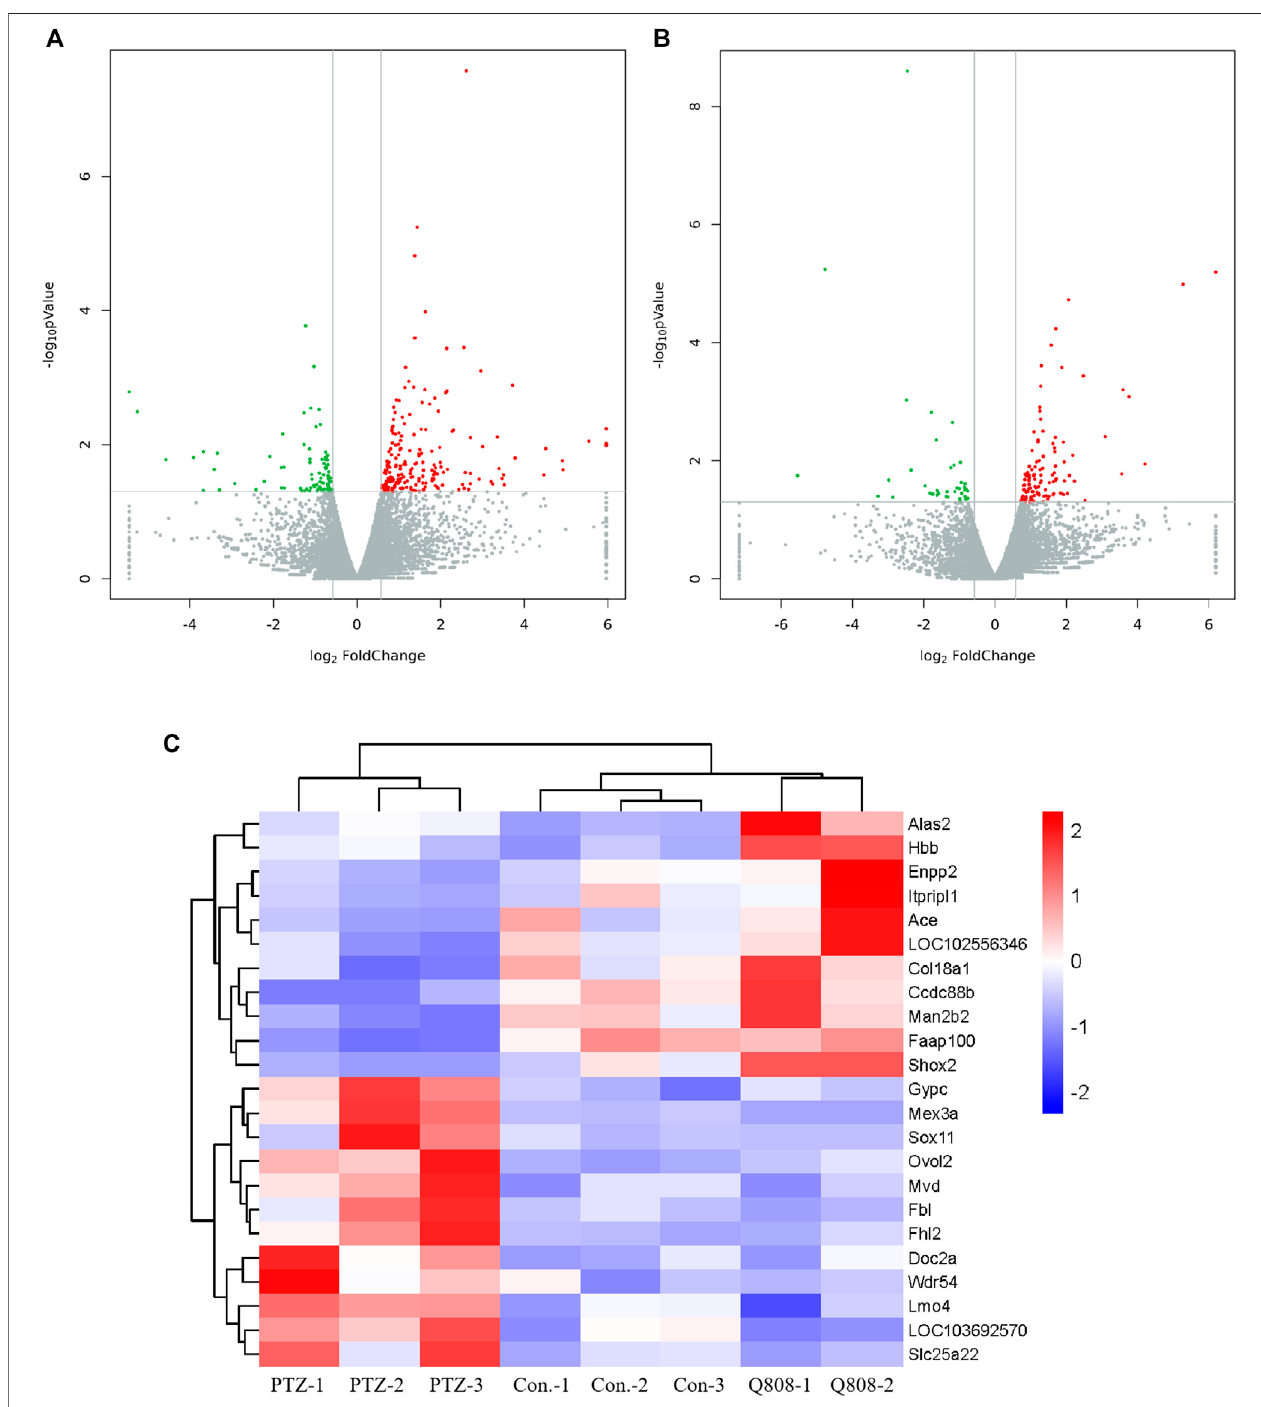
FIGURE 3 | Volcano plot and heatmaps of hub genes in the hippocampus. (A, B) Volcano plot showing up-regulated (red dots) and down-regulated (green dots) DEGs and normal expressed genes (gray dots). (C) Heatmap showing the expression level of 23 hub genes across the three groups. Blue and red colors represent low and high levels of expression, respectively. Corresponding hierarchical clustering analysis of these hub genes is shown in black bars.